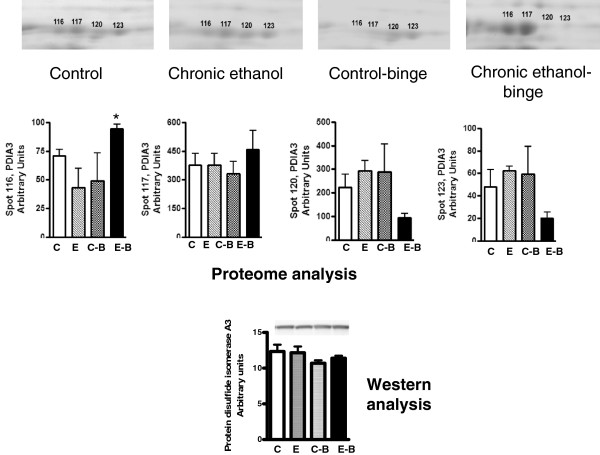
Quantitative analysis of PDIA3 from 2D gels and western immunoblot analysis. Sample preparations were similar to that in Figure 1. The upper panel shows 2D proteome profile of the 4 treatment groups (see Figure 1). The spots (# 116, 117, 120 & 123) were quantified and data are presented in the histograms (middle panel). The bottom panel shows western immunoblot using antibody for PDIA3 in the four group samples. Values are mean ± SE (n = 3 rats for each group). Western blot represents a typical experiment. *significant from control group (p < 0.05); C: Control (pair fed); E: Chronic ethanol; C-B: Control- ethanol binge; E-B: Chronic-ethanol binge.